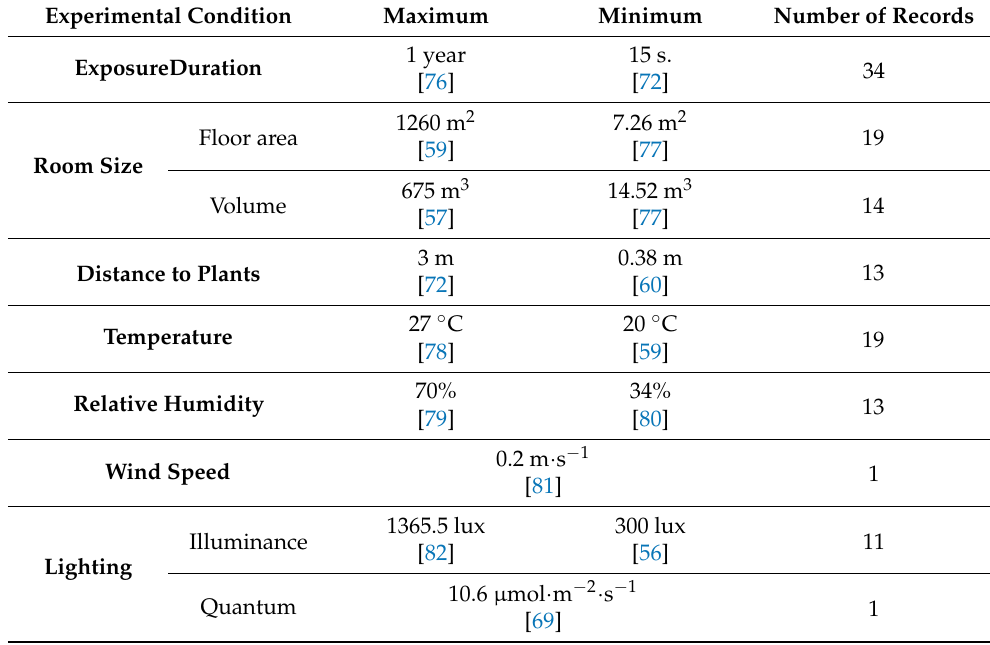
Table 3. Statistics of experimental